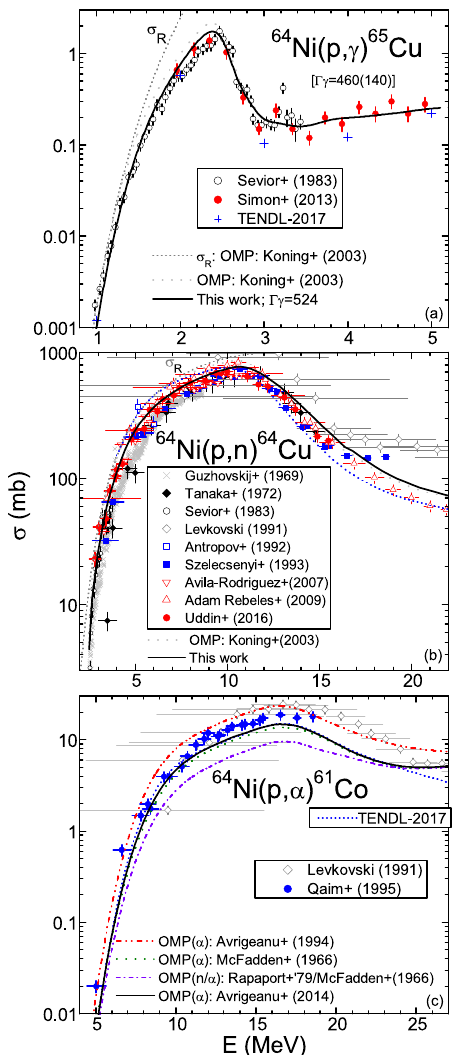
Figure 2. As Fig. 1 but for 64 Ni( p , x ) reactions, except the use of OMPs [19] (a,b) and [20, 21] (c) (dotted).